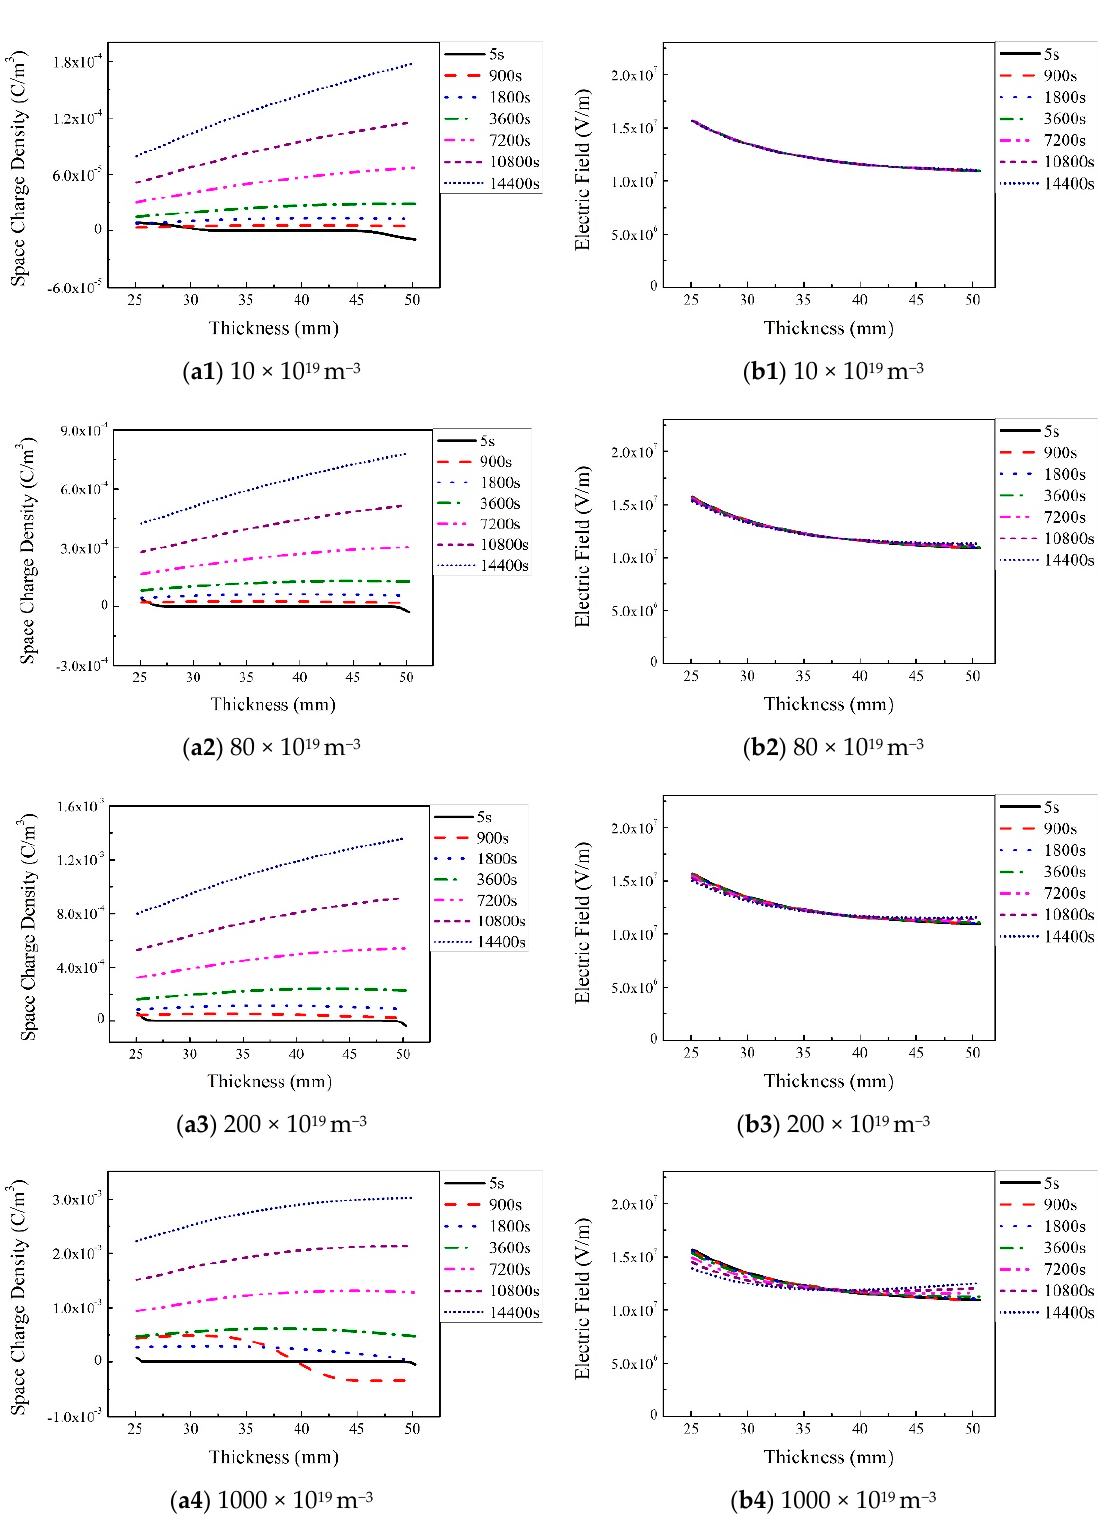
Figure 6. Simulation results of space charge distribution ( a1 - a4 ) and electric field distribution ( b1 - b4 ) in 320 kV HVDC cable insulation when the trap density varies from 10 × 10 19 m − 3 to 1000 × 10 19 m − 3 with the trap depth of 0.80 eV and load current of 1800 A.